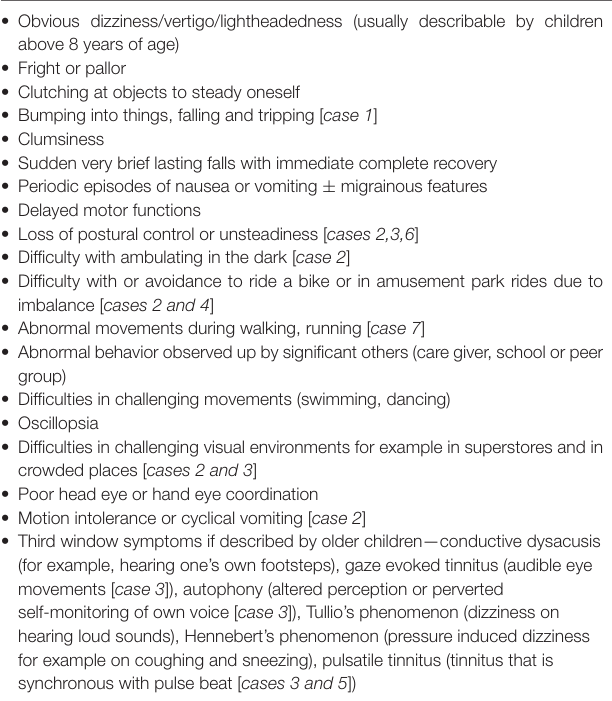
TABLE 2 | Symptoms of pediatric vestibular disease [table adapted from (5)]; children with specific symptoms in the series in brackets and